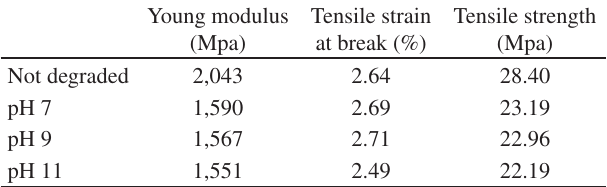
Table 7. Mechanical properties of PHB after accelerated degradation in soil.